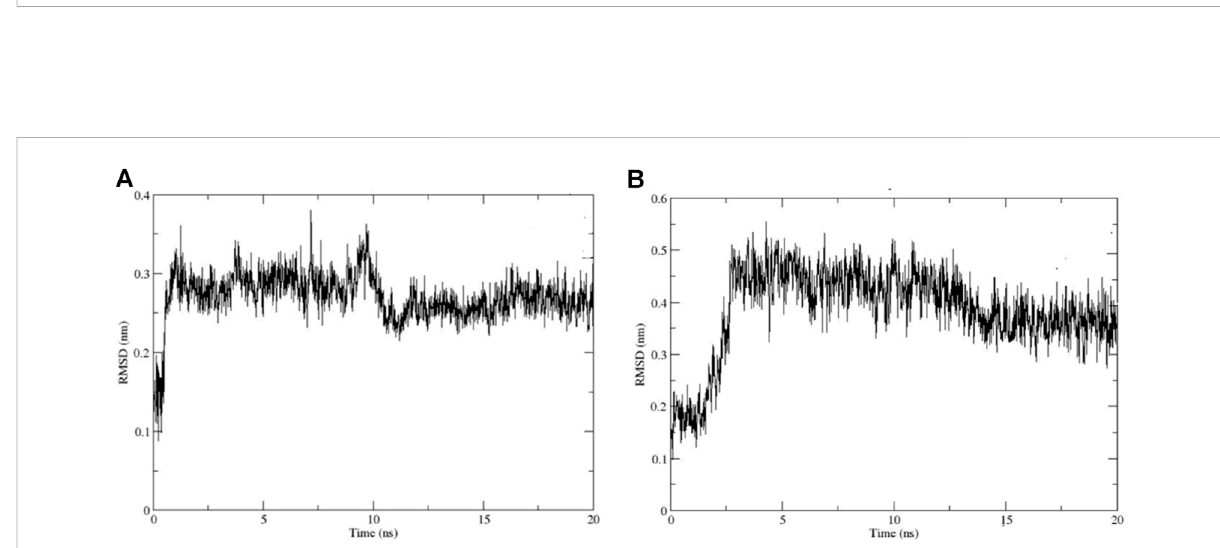
FIGURE 7 RMSD Plots for (A) Compound 11 -AChE complex (B) Compound 13 -AChE complex.